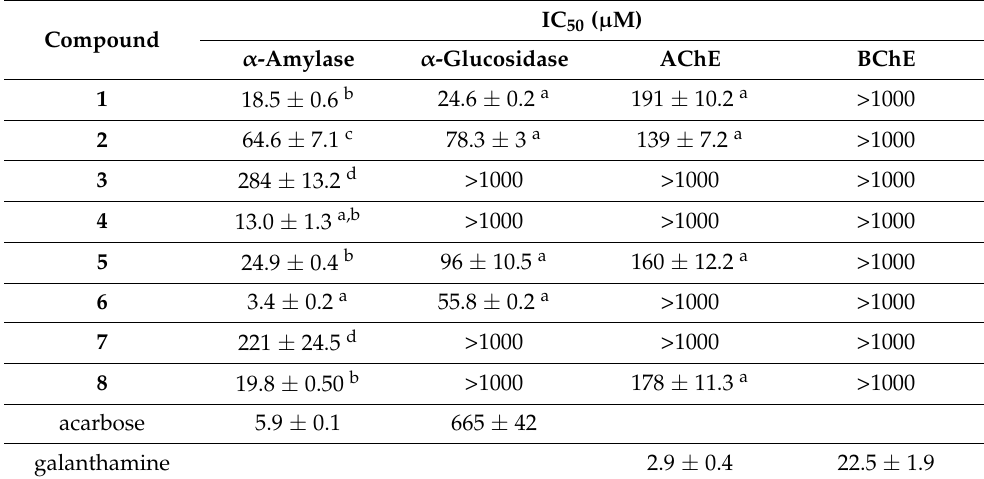
galanthamine 22.5 ±